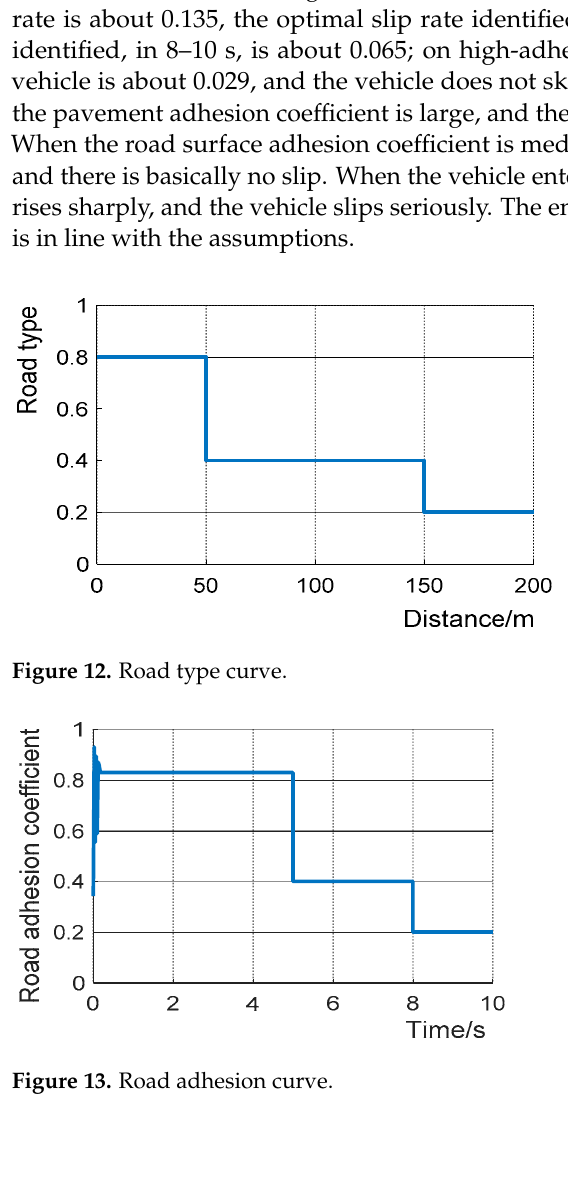
Figure 14. The actual slip rate curve. Figure 15. The optimal slip rate curve. In summary, under different conditions of the road surface, the road surface recog- nition module can quickly recognize the current road surface condition and estimate the optimal slip rate of the current road surface. The recognition result conforms to the pre- set road surface law. 4.2. Slip Rate Control Module Verification Based on the road surface recognition module’s estimation of the relevant parame- ters of the current road surface, the estimated value of the optimal slip ratio is obtained to adjust the driving torque in the slip rate control, and the actual slip ratio of the four-wheel independent drive electric vehicle is controlled in the optimal range. The road conditions are as follows: the vehicle starts to travel 50 m on the high-adhesion road, then joins the road to 150 m, and then enters the low-adhesion road until the end of the simulation experiment. The simulation results are shown below: From Figures 16–19, it can be seen that on high and medium viscosity roads, the driving torque and acceleration of the motor do not change. With a given road adhesion coefficient, the road surface adhesion coefficient remains basically unchanged, and the slip-rate control module does not work. When driving on a low-adhesion road, the mo- tor torque does not change substantially without control, the vehicle seriously slips, the road surface adhesion coefficient is about 0.2, and the motor torque is drastically re- duced when the slip ratio control module is operating. The acceleration and adhesion coefficient of the vehicle are also slightly reduced, and the vehicle slips, but all are with- in the optimal slip rate range.